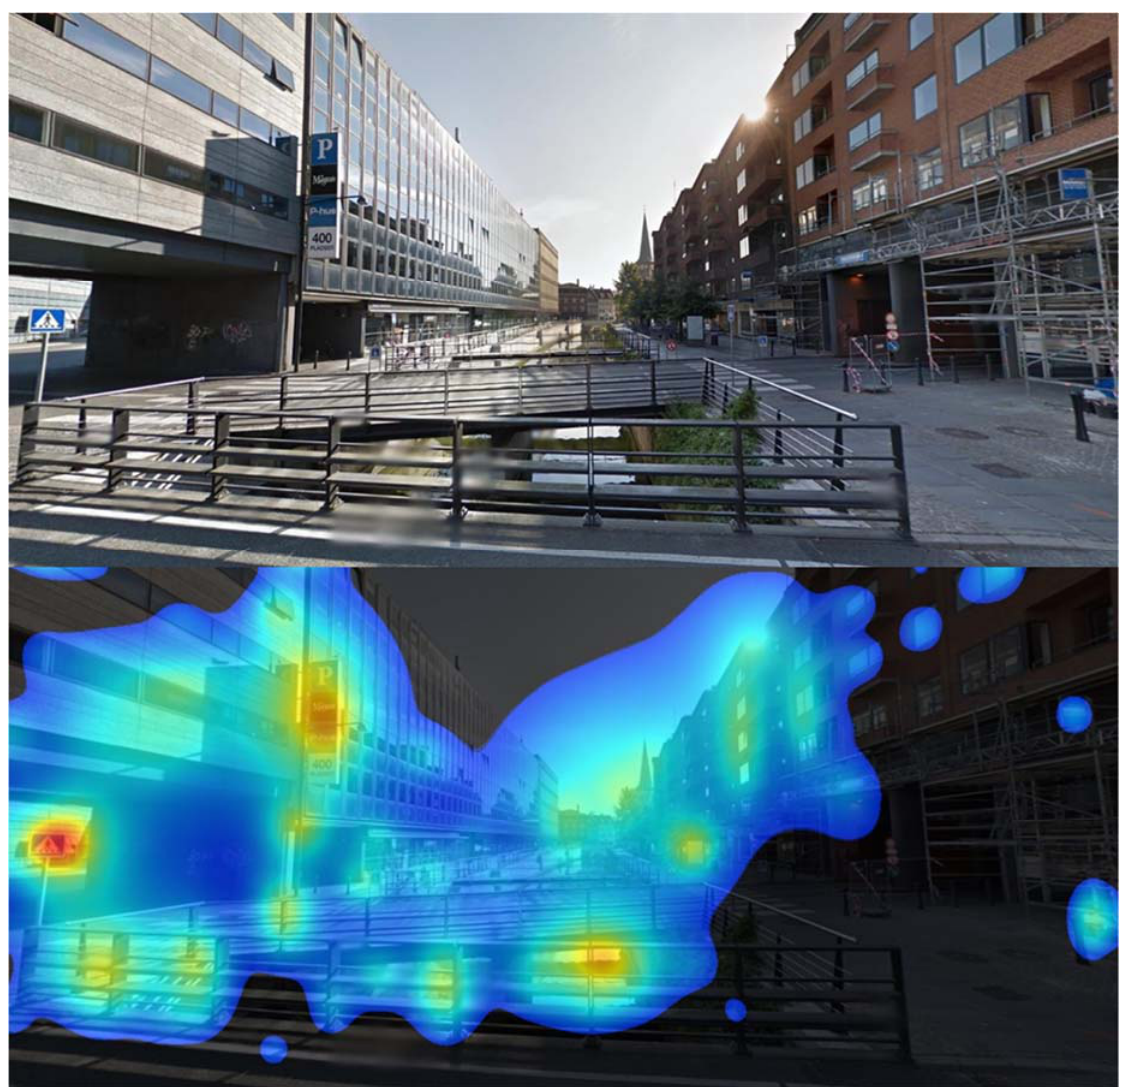
Figure 1. That which is perceived in a purely Modernist environment is perceptually meaningless. Top: The Center City Aarhus River is a functionalist concrete drainage channel set in an intolerably harsh cityscape. Image retrieved from Google Maps. Bottom: The Center City Aarhus River analyzed using 3M’s Visual Attention Software (VAS). Eye tracking data and visualization by N. H. Buras.